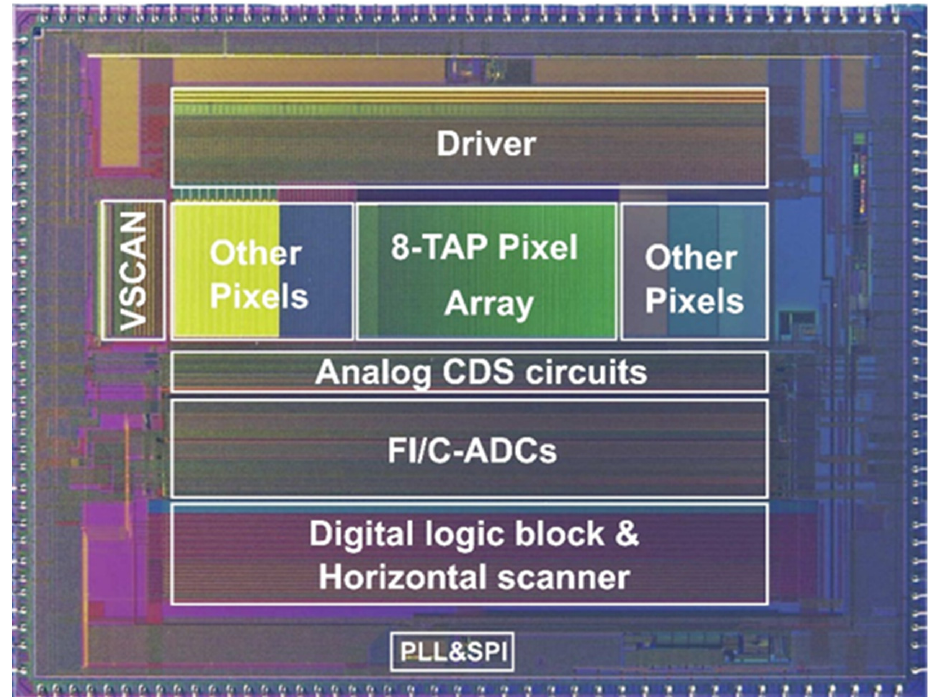
including a 120 (H) × 60 (V) array with the 8-tap PND pixels and other arrays of test pixels in the size of 9.34 mm (H) × 7.04 mm (V). The 9-phase gating clock signals for driving G 1 through G 8 and G D are supplied from outside FPGA and are given to the 8-tap PND pixel array through a driver. Using 4 parallel signal lines per pixel (22.4 µ m pitch) and a column ADC [35] with pitch of 5.6 µ m, 4 of 8 outputs from each pixel are read out and converted to 16 bit digital signals in parallel. One row of pixel signals each of which is half of 8-tap pixel outputs is horizontally scanned and read out using an LVDS (low-voltage differential signaling) interface. The column ADC used is the folding integration/cyclic ADC using a multiple sampling technique [35]. The readout time of the one row of the pixel signals takes 80 µ s including the times required for the analog-to-digital conversion and digital CDS. The total readout time for reading one frame image signal, i.e., the time reading 120 rows, each of which consists of two sets of 4 parallel signals from the 8-tap pixel, is 9.6 ms (=120 × 80 µ s). The input-referred noise of the ADC is 130 µ V rms , which is sufficiently low compared with the noise originated by the pixel behavior of the designed chip. A relatively low conversion gain (measured: 10.8 µ V/e − ) is used in order to have a sufficiently high full well capacity (measured: 79.2 ke − ). The fill factor defined by the ratio of the area of demodulation to pixel size is 9% and using a microlens, the quantum efficiency is 14.5% at 940 nm. The read noise of the major component is the kTC noise 745 µ V rms , or 69 e − rms .